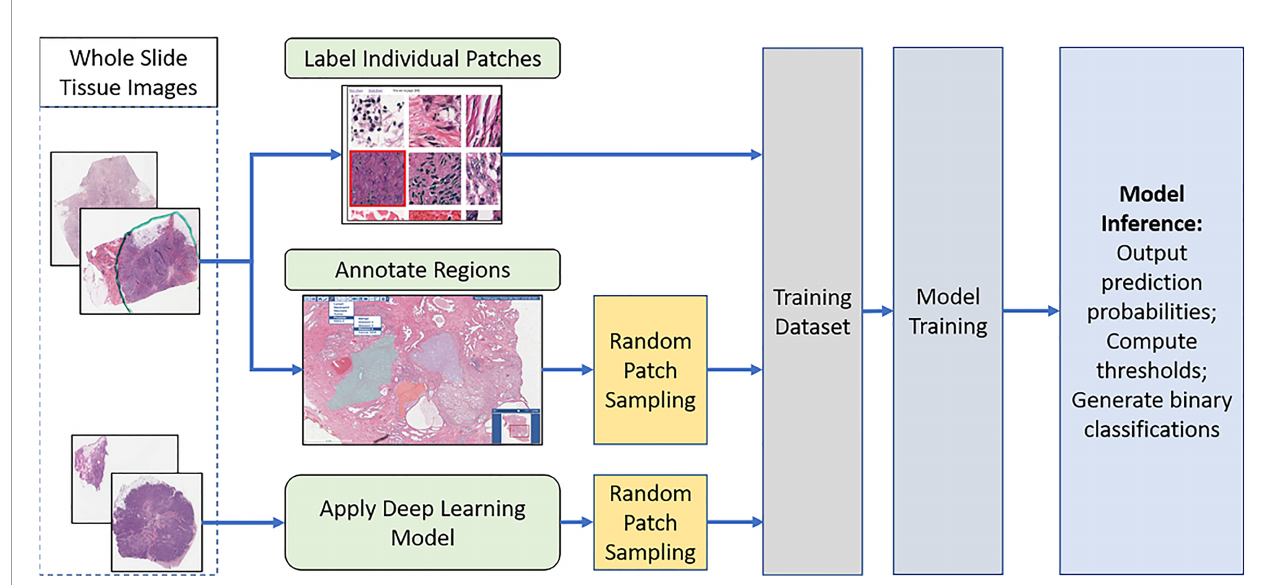
FIGURE 2 | The overall analysis work fl ow: Training data generation, model training, inference (prediction), and computing threshold values. Training data is generated via a combination of manual annotations and model-generated predictions. A trained model generates predictions in the form of the probability that a patch is TIL-positive. The probability values are mapped to binary classi fi cations by applying an automatically computed threshold.